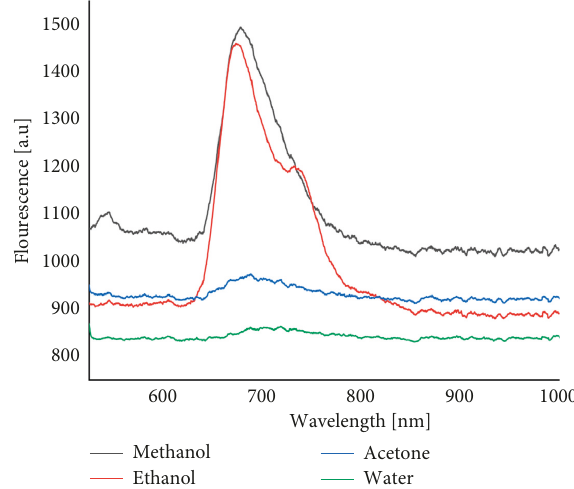
Figure 4: Fluorescence spectra for photosensitizer for each solvent, methanol, ethanol, acetone, and water, with the presence of ab- sorption and scattering components.